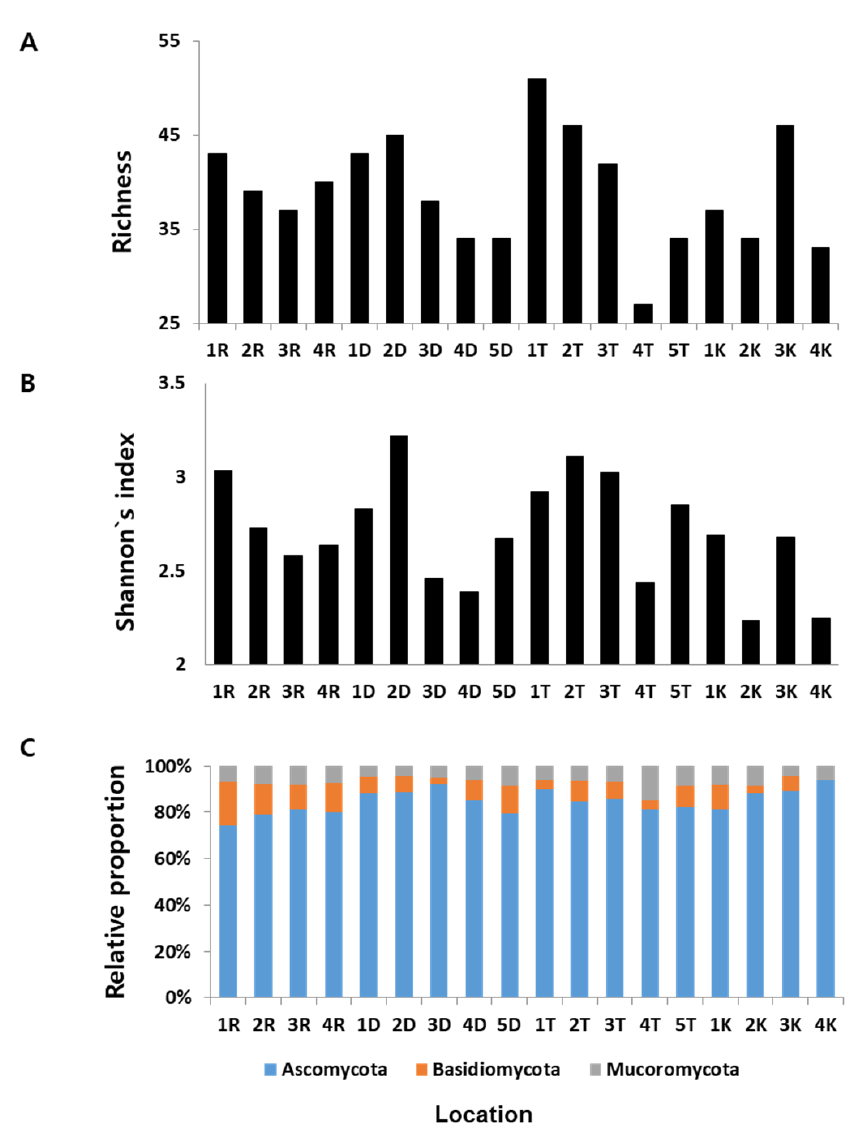
Figure 3. Distribution and diversity of fungal endophytes among sites. ( A ) Species richness across the sampling sites. ( B ) Shannon index (H’) across the sampling sites. ( C ) Relative proportion of fungal endophytes at phylum level across 18 sampling sites. Letters R, D, T, and K represent the Pinus species rigida , densiflora , thunbergii, and koraiensis , respectively. We also analyzed the relative proportion of each phylum recovered from all sampling sites. As shown in Figure 3C, Ascomycota was found to be the most dominant phylum in all sites. The highest number of fungal endophytes belonging to Mucoromycota was recorded in site 4T. In the case of Basidiomycota, site 1R showed the highest number of fungal endophytes belonging to this phylum. No significant differences on the composition of fungal endophytic community were observed among different sampling sites (Supple- mentary Figures S1 and S2), although some specific site parameters (Ca and Mg ions and altitude) vary significantly (Supplementary Table